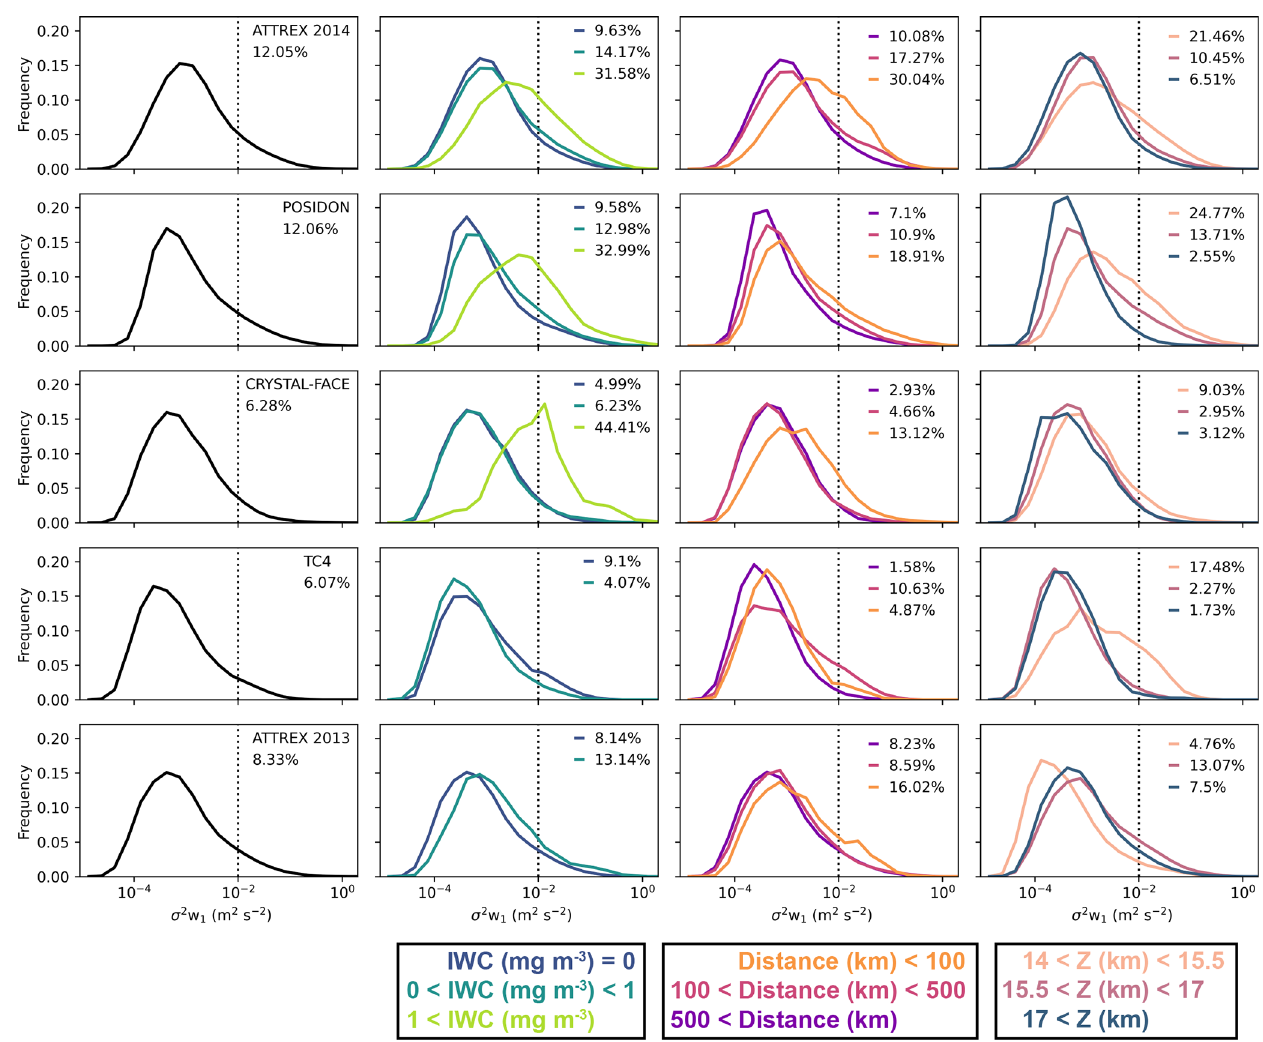
Figure 4. Same as Fig. 3 except showing distributions of high-frequency ( > 1Hz) vertical wind variance ( σ 2 w 1 ). The percentage of data exceeding the turbulent threshold (0.01m 2 s − 2 ; vertical dotted line) for each category is shown on each